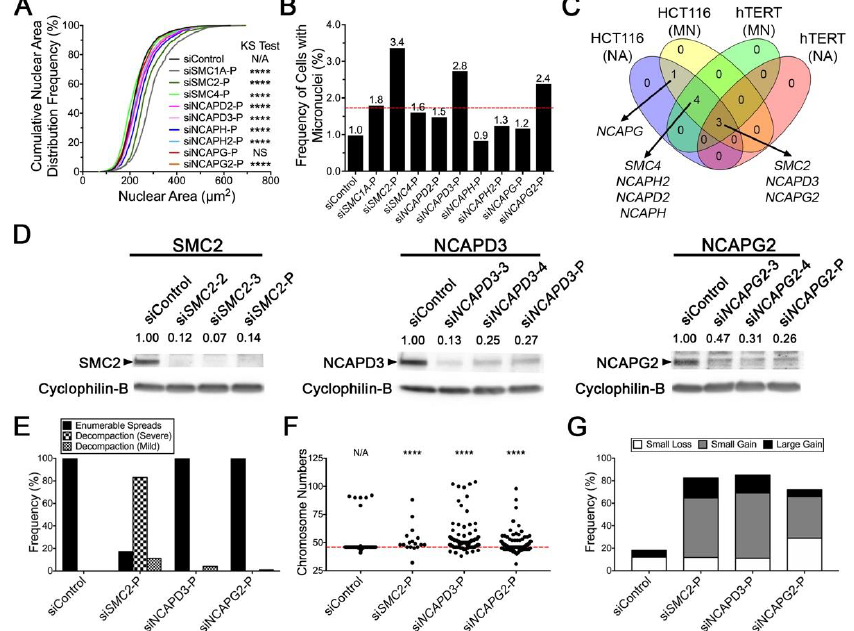
Figure 5. Condensin gene silencing induces increases in CIN phenotypes in hTERT cells. ( A ) Cumulative NA distribution frequencies following condensin gene silencing in hTERT cells relative to siControl (black). KS tests reveal reduced expression induces statistically significant changes in NA distributions, with the exception of NCAPG ( p = 0.07) (N/A, not applicable; N/S, not significant ( p > 0.01); ****, p < 0.0001). ( B ) Column graph presenting the frequency of MN formation following silencing. The fold increase in mean MN formation relative to siControl is presented above each column, while the horizontal line identifies the minimum threshold to be considered a significant increase. ( C ) Venn diagram presenting the results of the NA and MN formation assays performed in both HCT116 and hTERT cells. Note that SMC2 , NCAPD3, and NCAPG2 silencing induced significant phenotypes in all four assay / cellular contexts. ( D ) Representative Western blots showing SMC2 (left), NCAPD3 (middle) and NCAPG2 (right) levels following silencing in hTERT cells with both individual and pooled siRNAs; Cyclophilin B is the loading control. Semi-quantitative image analysis was performed, and residual protein levels are presented relative to siControl (1.00). See Figure S2 for detailed information. ( E ) Bar graph showing the frequency of enumerable mitotic spreads versus those with severe or mild chromosome decompaction phenotypes. Note that the majority of SMC2 silenced cells present with decompaction phenotypes, including ~83% and ~11% with severe and mild phenotypes, respectively. ( F ) Dot plot presenting the individual chromosome numbers for each enumerable mitotic chromosome spread, with the horizontal line identifying the modal chromosome number (46) of hTERT cells. Note that only 17% of spreads generated following SMC2 silencing could be enumerated due to the prevalent severe decompaction phenotype. KS tests reveal significant di ff erences in the distribution of chromosome numbers relative to siControl (N / A, not applicable; ****, p < 0.0001). ( G ) Bar graph depicting increases in the overall frequency of aberrant chromosome numbers relative to siControl, which includes small-scale losses, small-scale gains and large-scale gains. Note that only 17 / 100 mitotic chromosome spreads could be enumerated following SMC2 silencing, 14 of which, exhibited numerical deviations from the modal